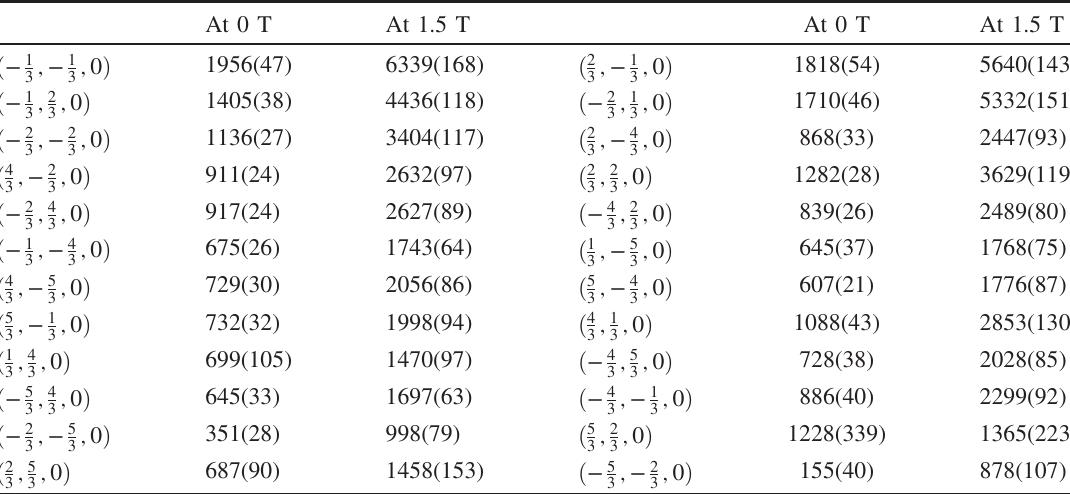
TABLE III. Intensities of the magnetic reflections measured at 60 mK. At 0 T At 1.5 T At 0 T At 1.5